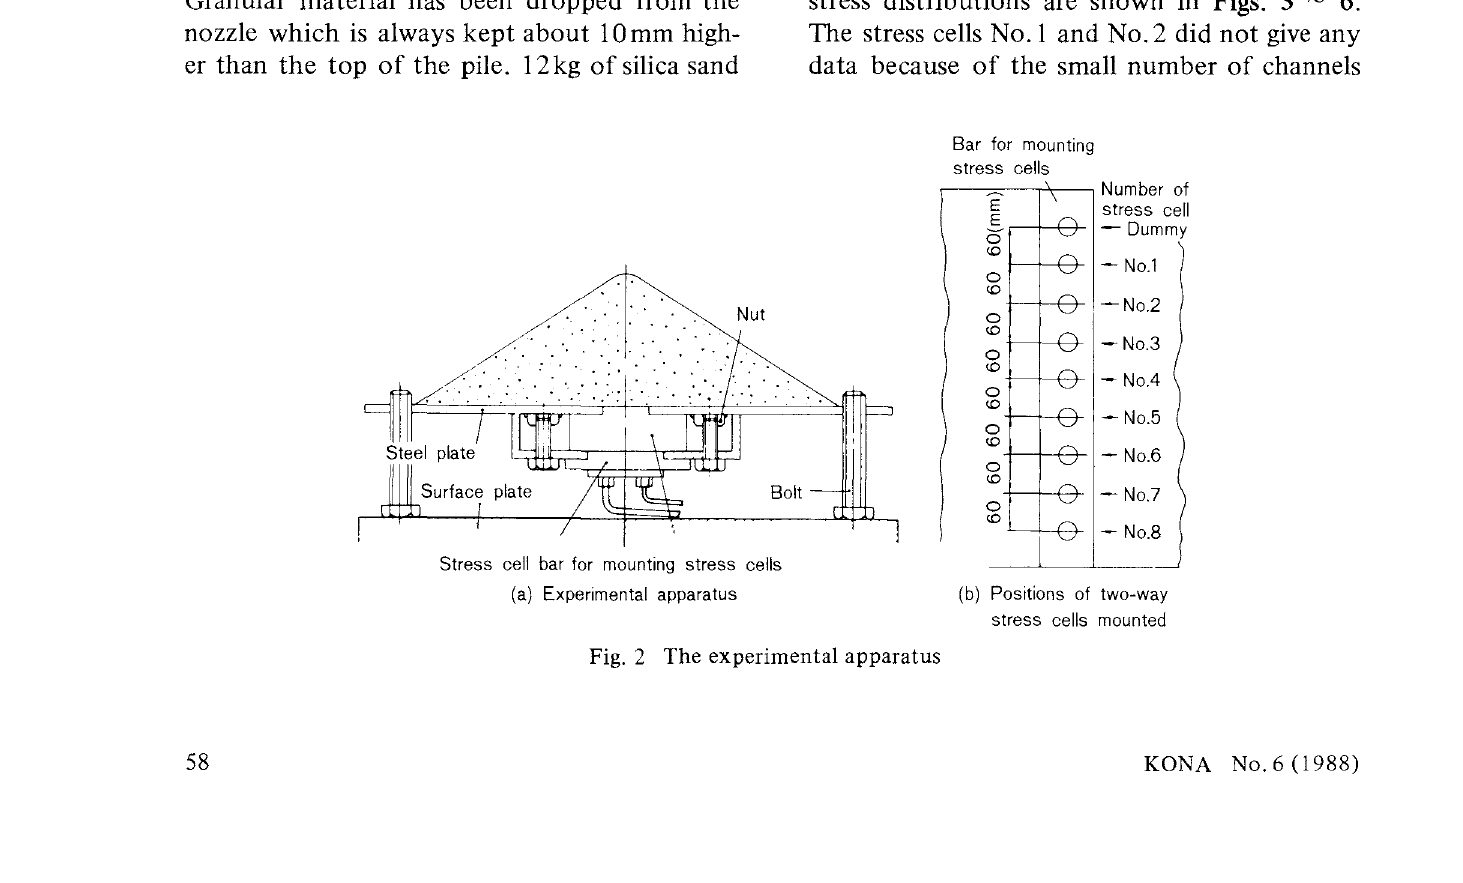
Table 1 Properties of used grains . .. -·--,- ... r---